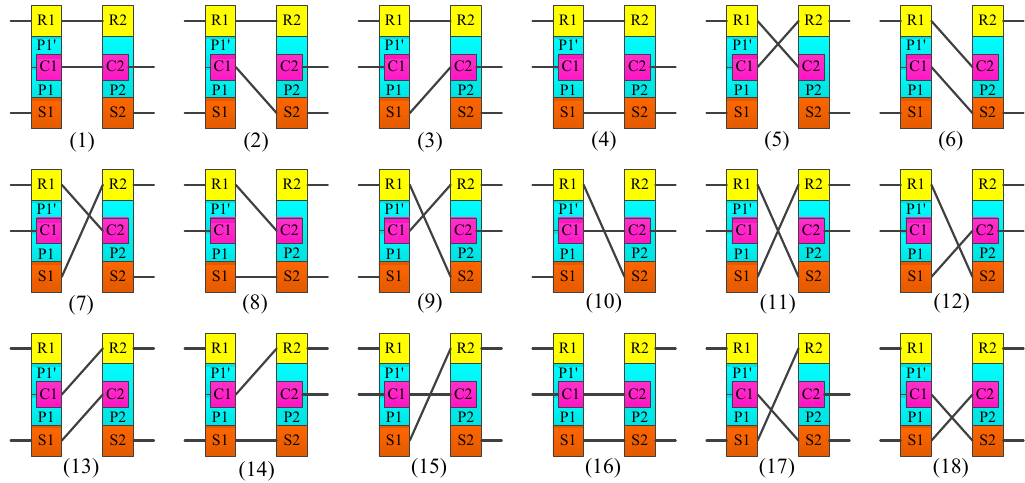
Figure 4. Atlas of eight-link mechanisms of motor transmissions.